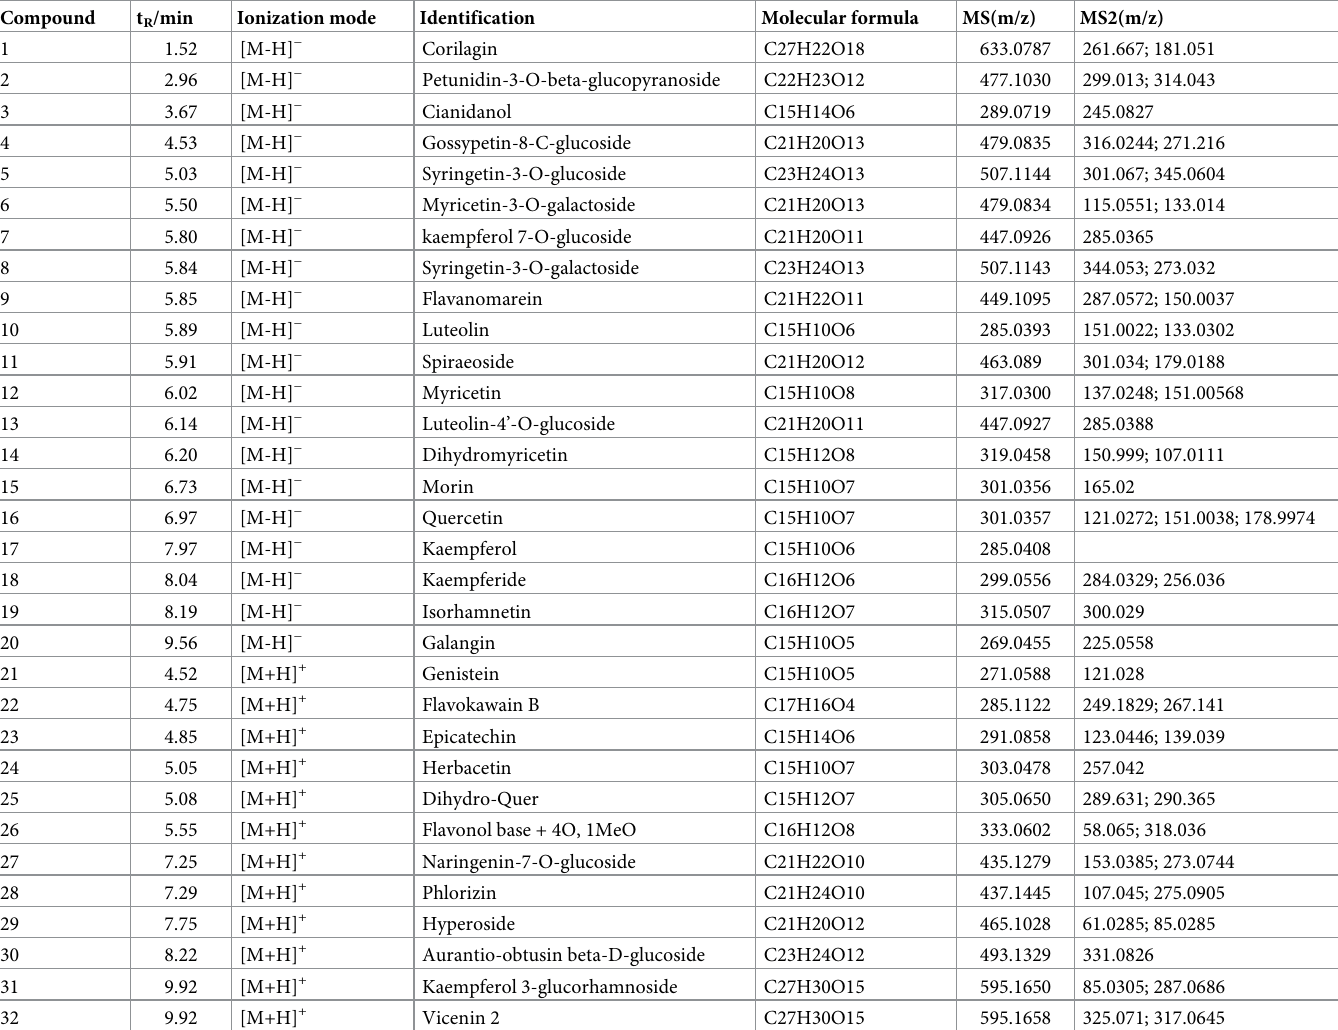
Table 4. Characterization of phenolic compounds of Berberis heteropoda fruit by UPLC-Q-TOF-MS E